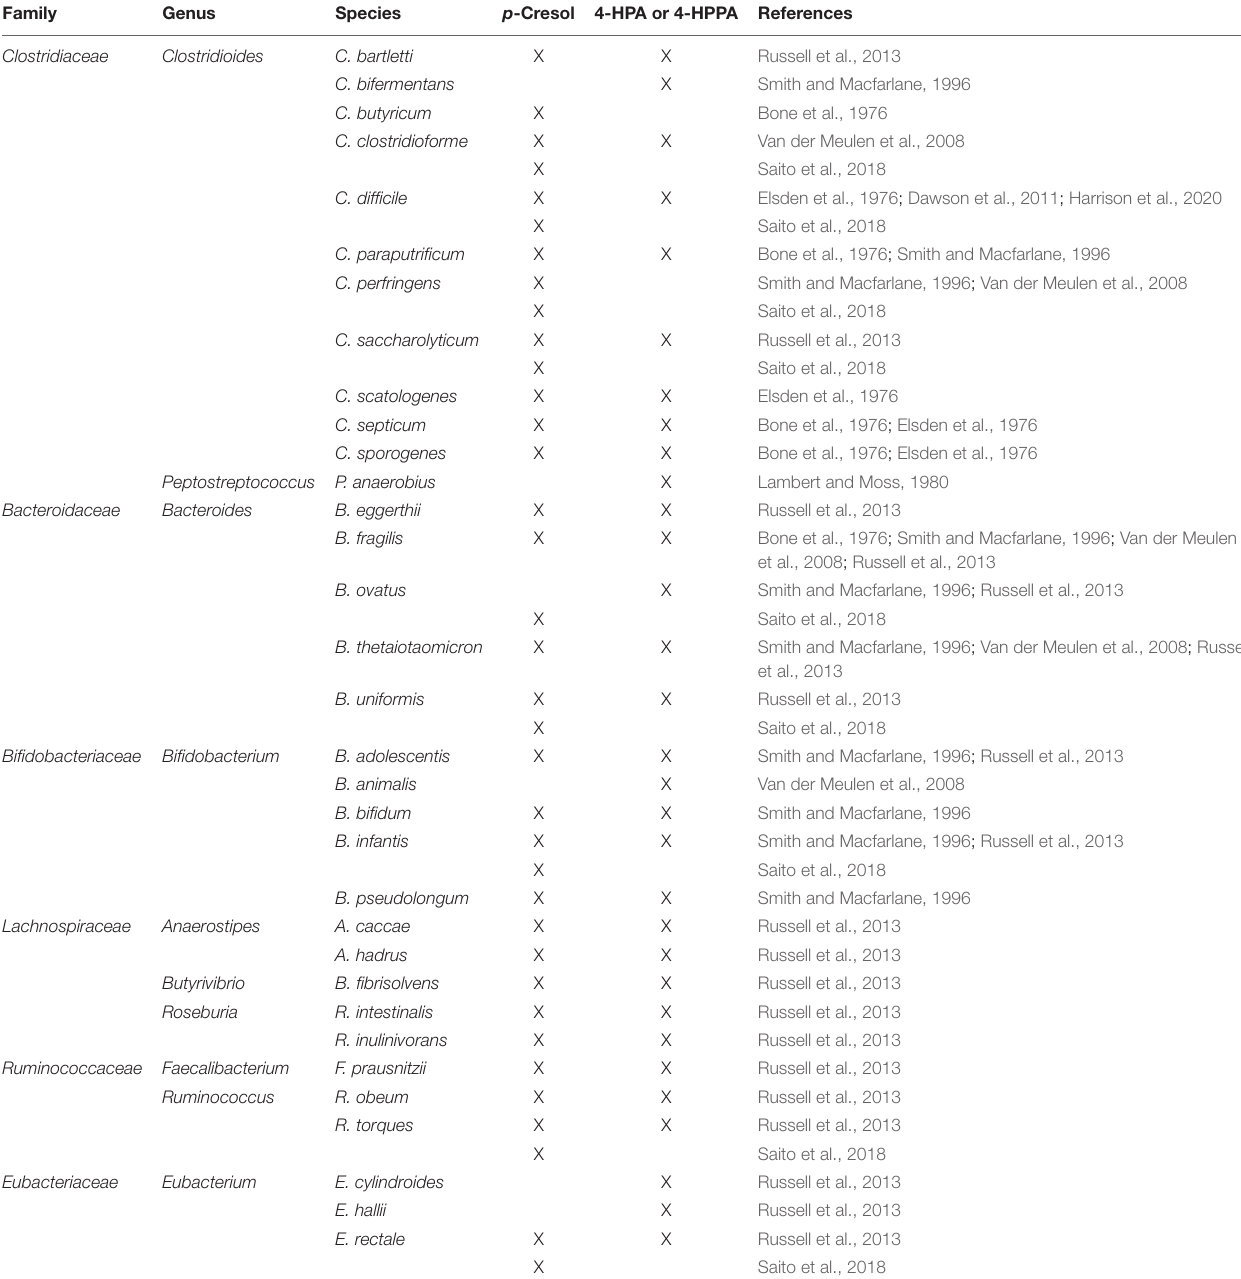
TABLE 1 | Overview of bacterial taxa producing p -cresol and/or 4-hydroxyphenylacetic acid (4-HPA) and 4-hydroxyphenyl propionic acid (4-HPPA).